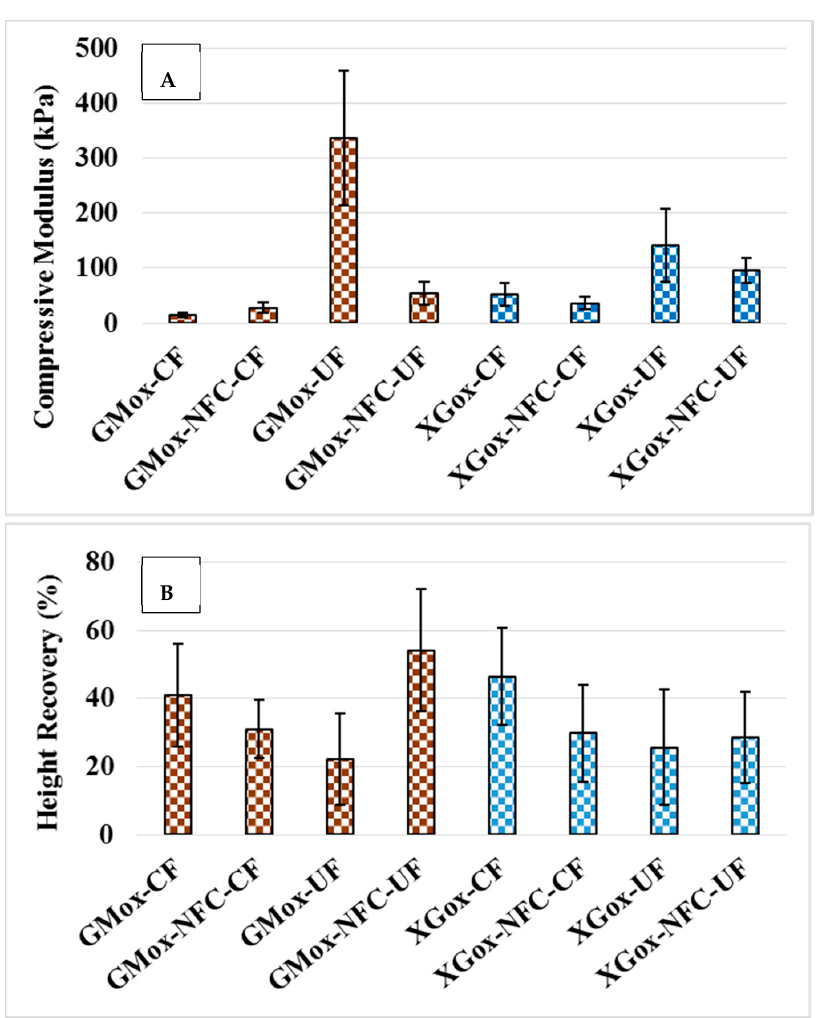
Figure 11. ( A ) Compressive modulus and ( B ) height recovery after the compression testing of the aerogels. GM = guar galactomannan, XG = tamarind xyloglucan, ox = oxidized, NFC = nanofibrillated cellulose, CF = conventional freezing, UF = unidirectional freezing.